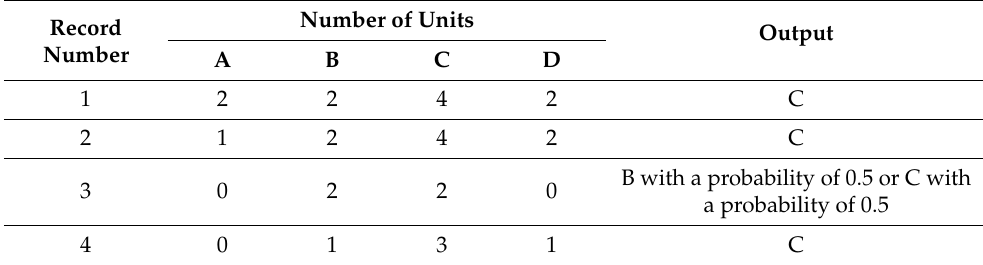
Table 6. The results obtained by improving method